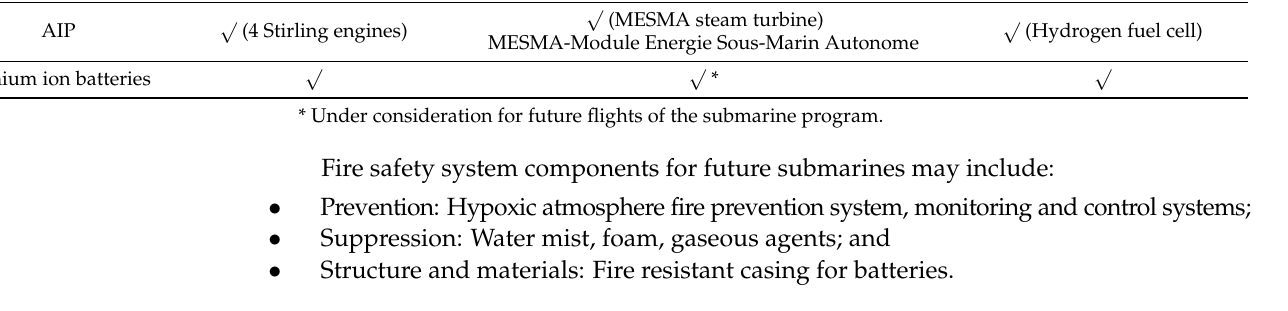
Table 2. Various Powering Options were considered for Australia’s Future Submarine. Options Soryu Class (Japan) Diesel engines